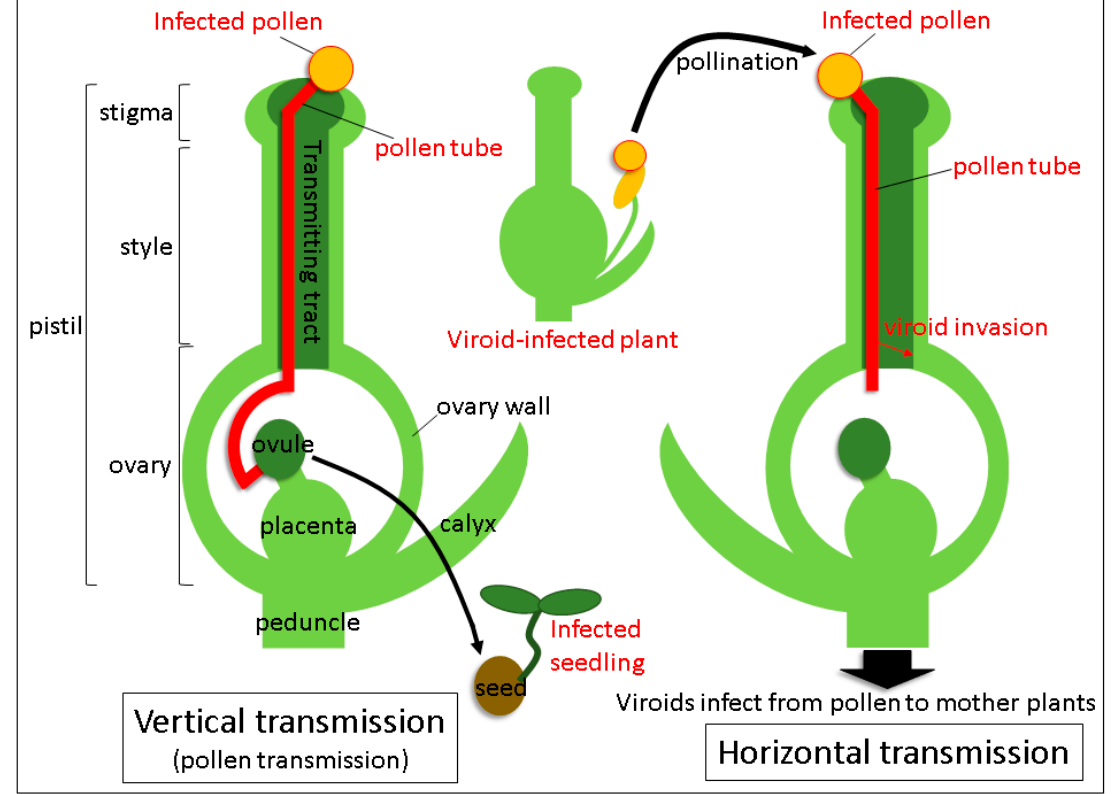
Figure 1. Pathways of tomato planta macho viroid during vertical and horizontal transmission through pollen in infected petunia plants.